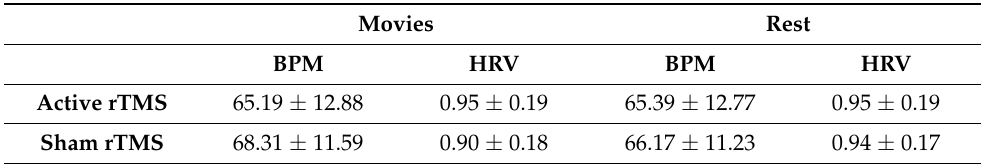
Table 2. Averaged beats per minutes (BPM) and heart rate variability (HRV) during movies and resting period for participants who received active or sham